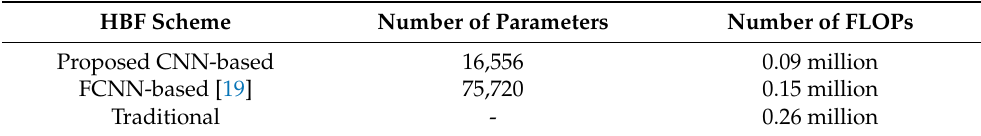
Table 2. Complexity comparison.